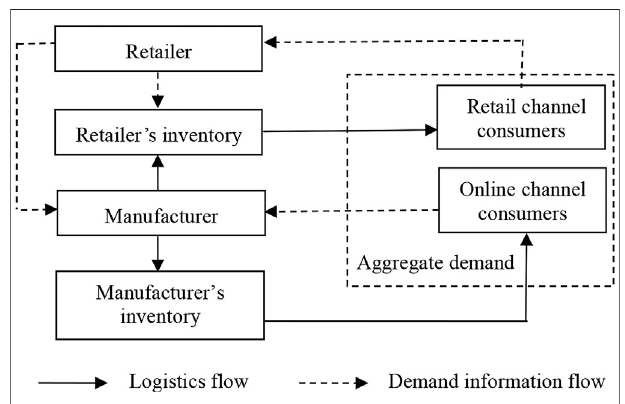
FIGURE 1 | Schematic diagram of inventory